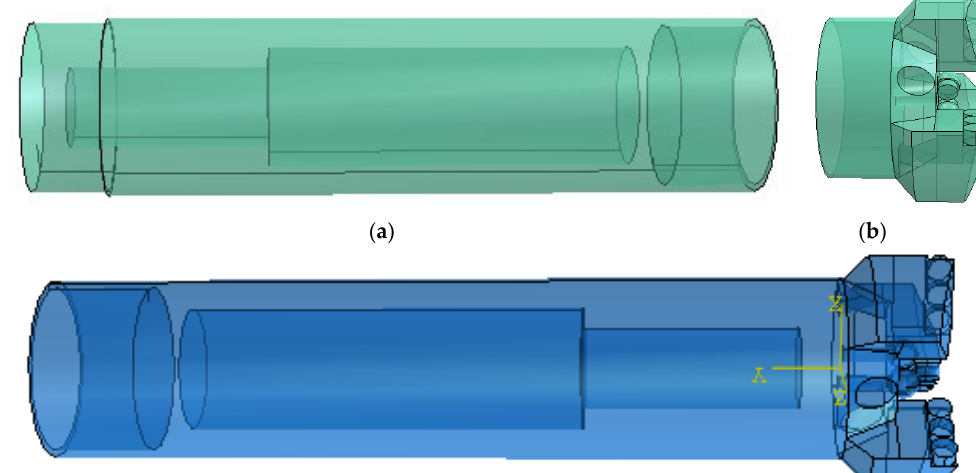
Figure 10. Thermometric tube size.